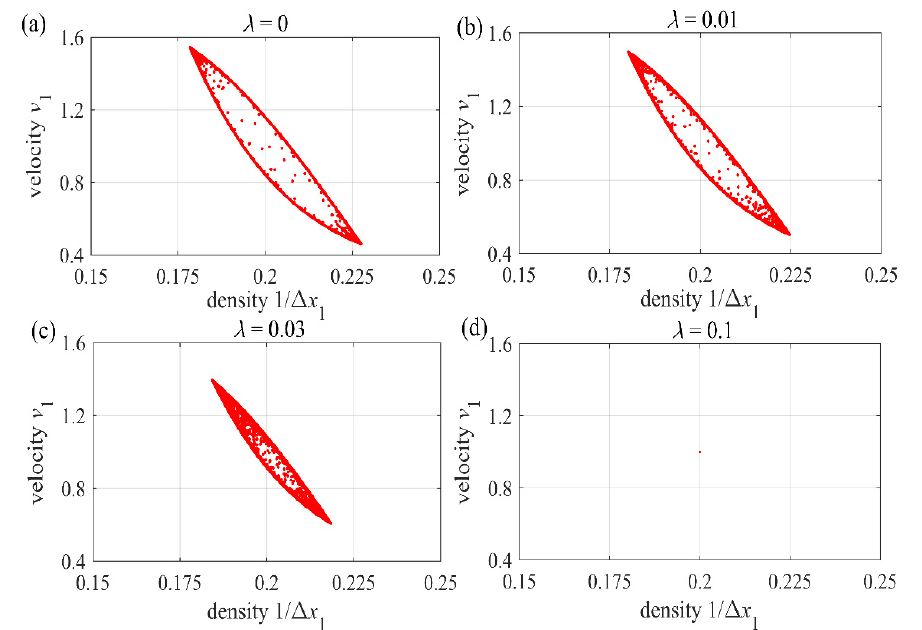
( ) v t and the densities 1